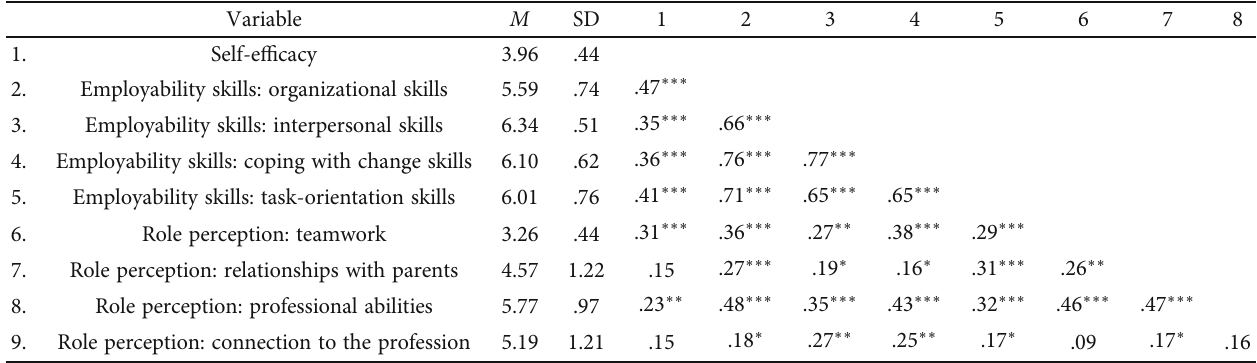
Table 1: Means, standard deviations, and correlations among study